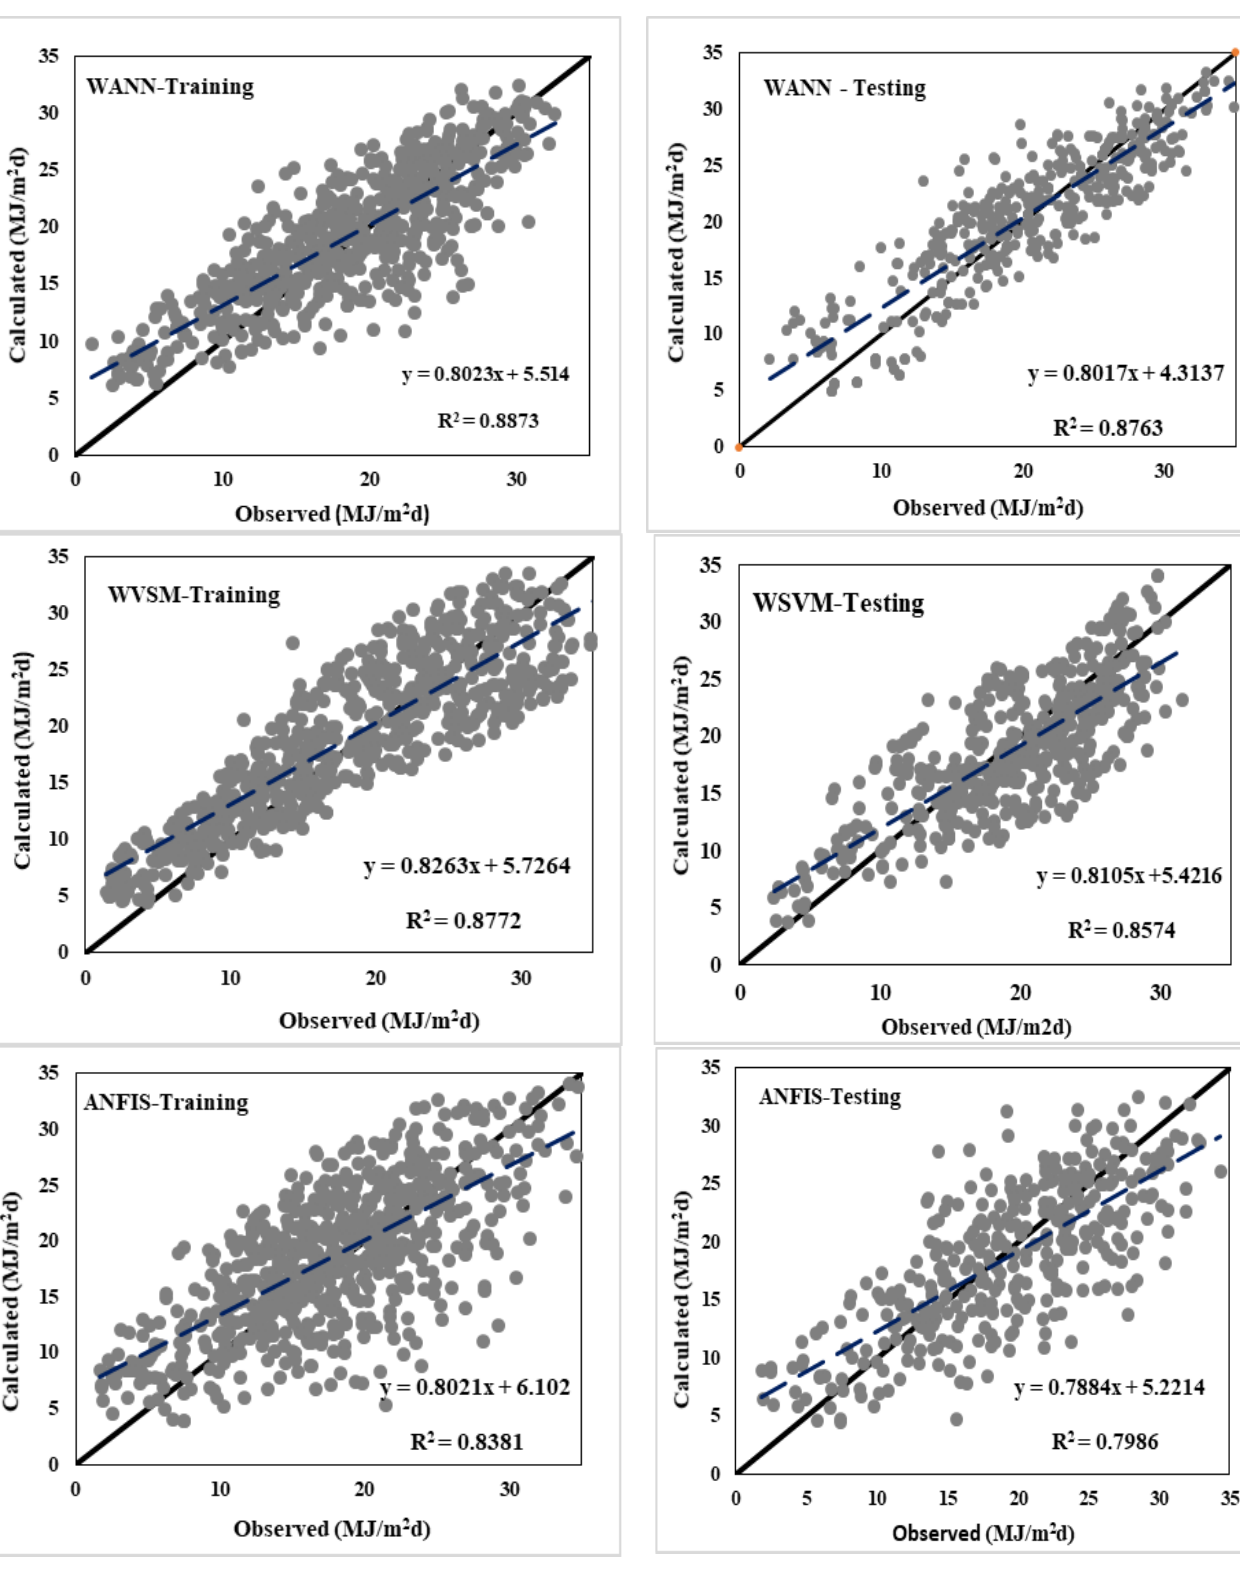
Figure 2. Correlation between radiation intensity (Rs) assessed by WANN, WSVM, and ANFIS methods and observed values at Wasit station in two stages of training and testing.